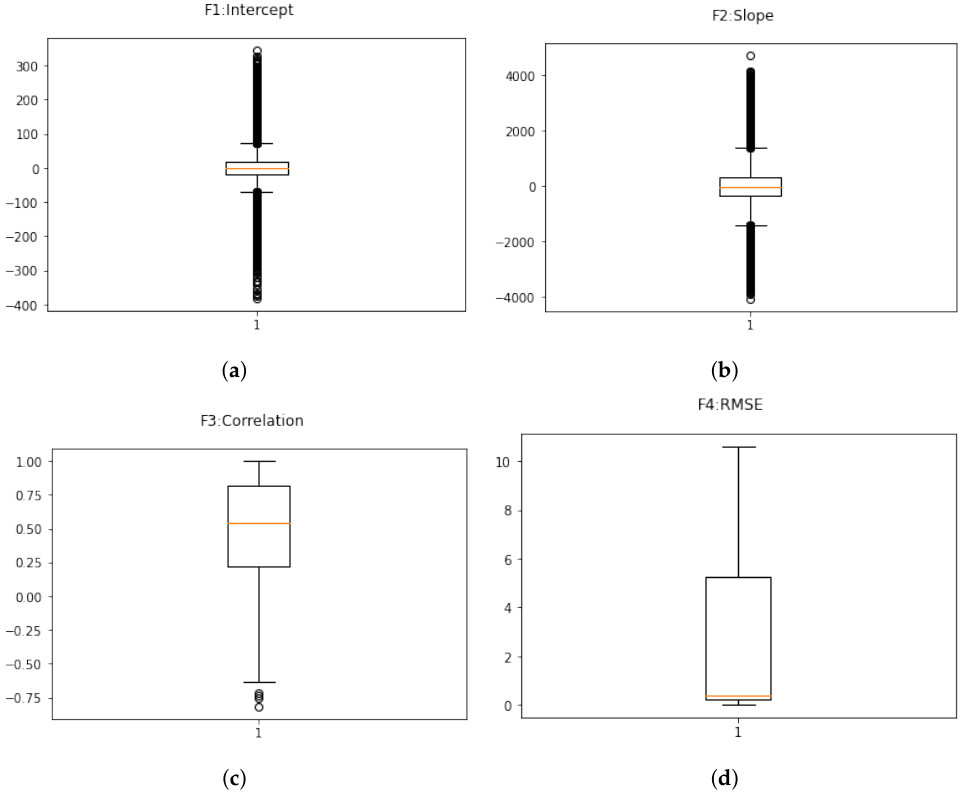
Figure 7. Box plot for each input feature in Dataset-1 (noise level from 10% to 50%). ( a ) m. ( b ) c. ( c ) R. ( d )